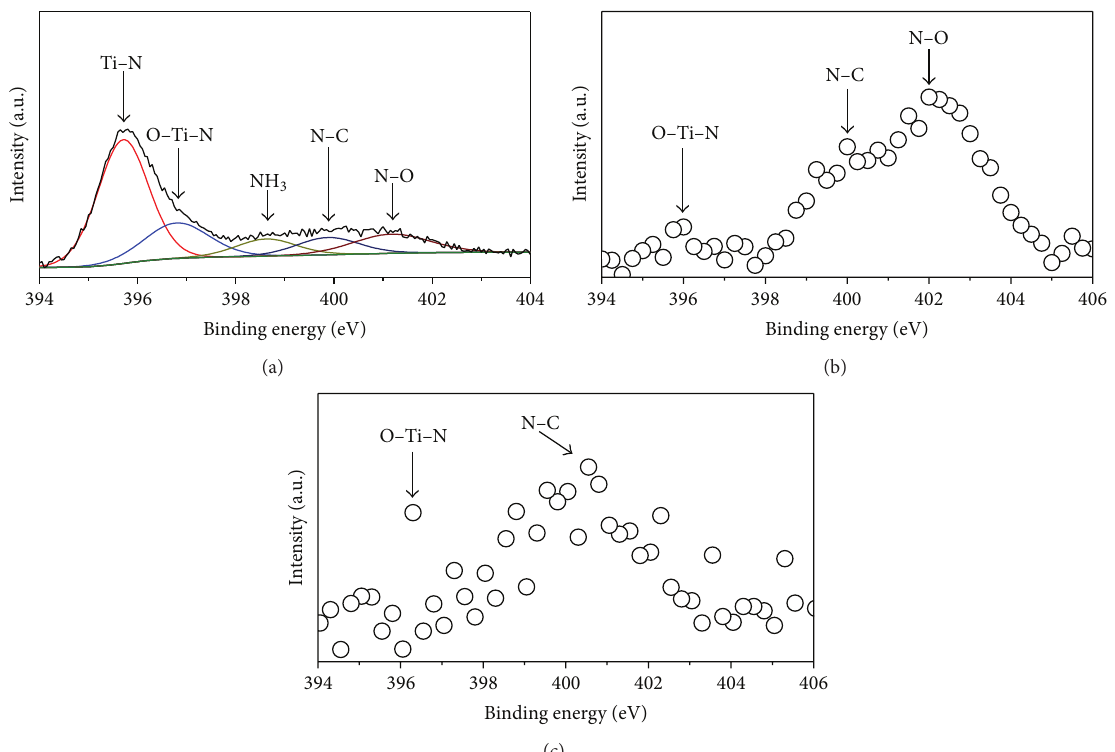
Figure 2: XPS spectra for N1s core level of the films deposited at (a) 0.2, (b) 0.6, and (c) 3.5